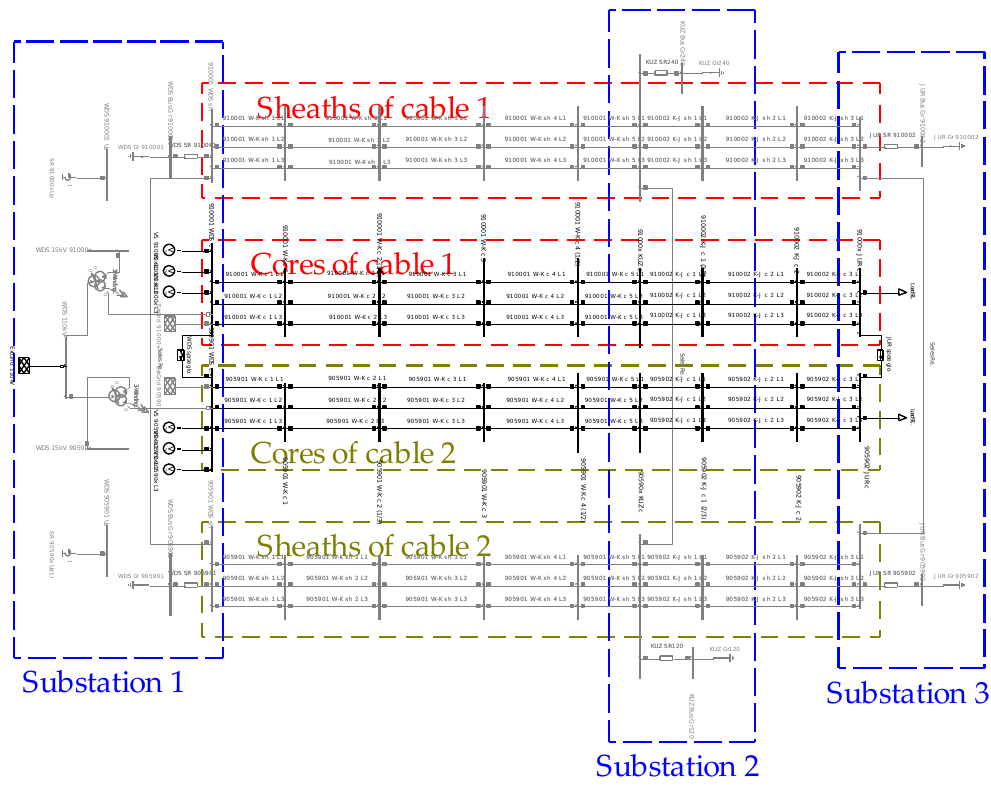
Figure 24. Cable lines system model in PowerFactory.